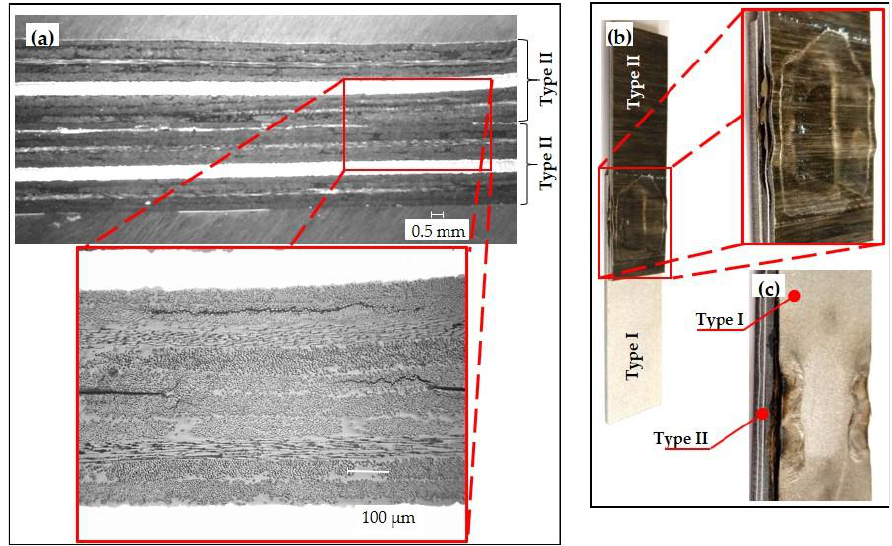
Figure 10. ( a ) Microscopic cross-section of ICJ type II+II samples with consolidation pressure of 2 bar, ( b ) sample I+II, 3 bar, with 5 kW induction power, and ( c ) sample I+II, same parameters as in ( b ), Type I is in the upper side.